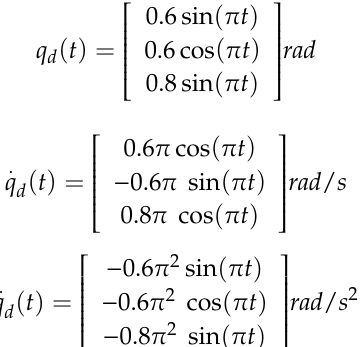
Figure 14. Control system diagram of the exoskeleton.